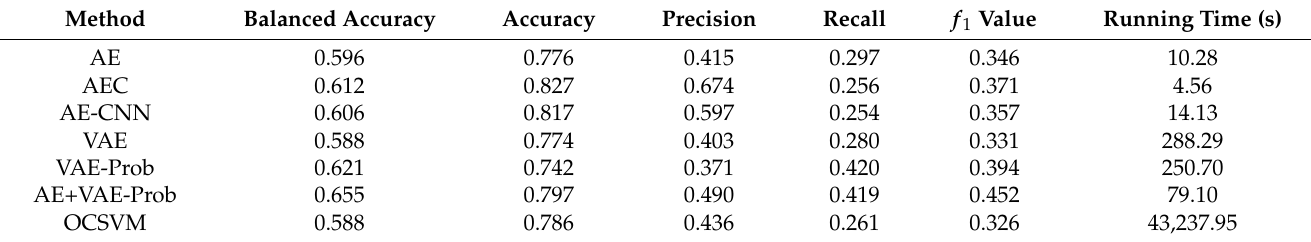
Table 8. Results for the detection of anomalies in the zero-day-attacks test